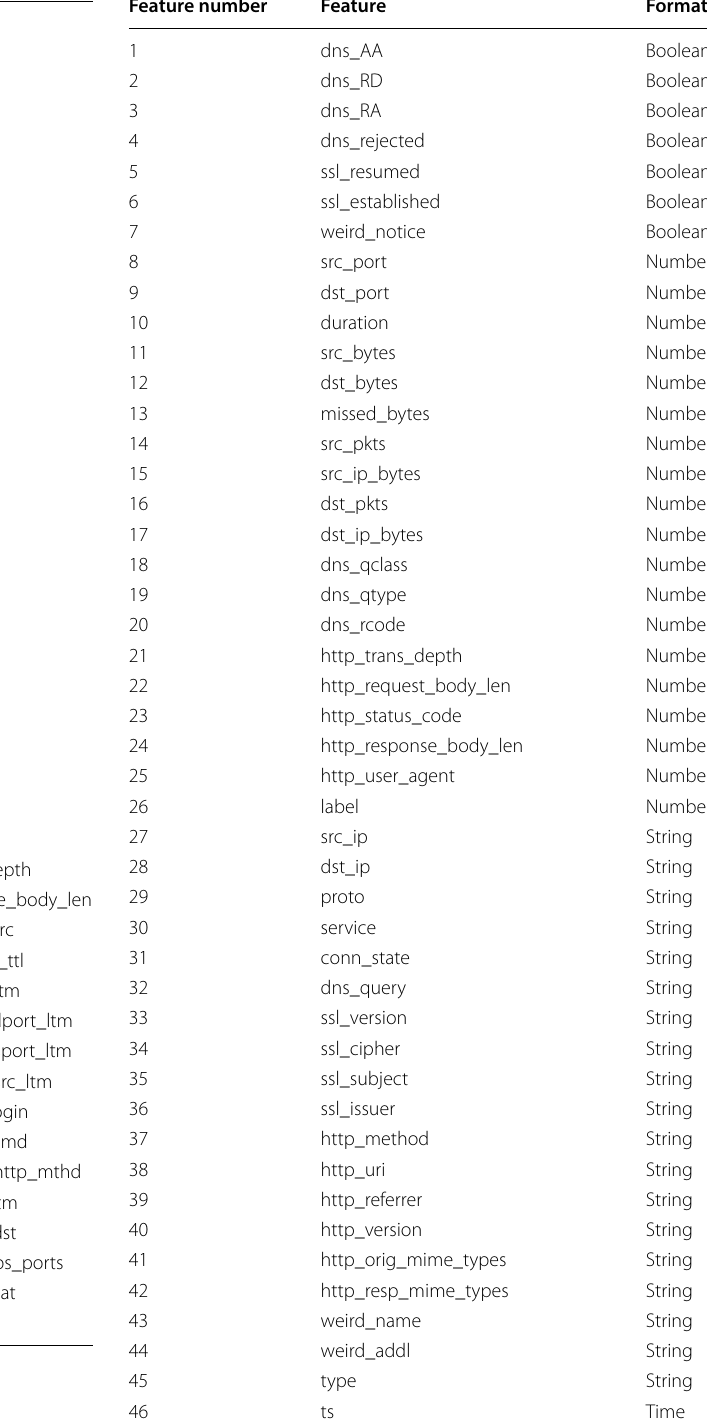
Table 2 List of features exist in UNSW-NB 15 Dataset Table 3 List of features exist in TON_IoT Train_Test